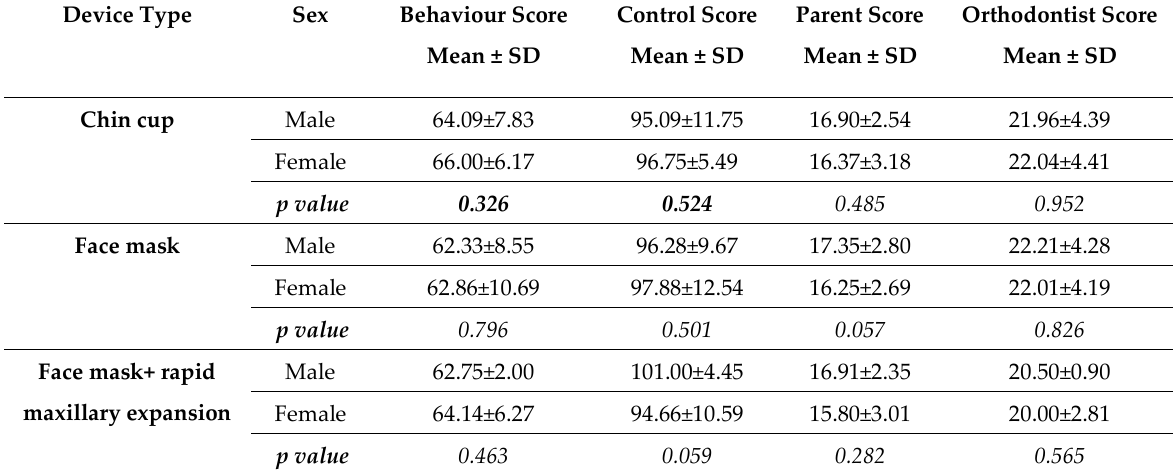
Table 7: Scale general scores by sex in detail on device